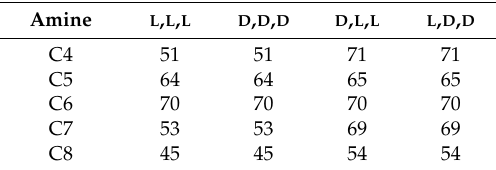
Table 1. T gel values ( ◦ C) for peptide dendrons denoted by their chirality, with different non-chiral amines (C4–C8) in toluene. [Dendron] and [amine] both 10 mM.